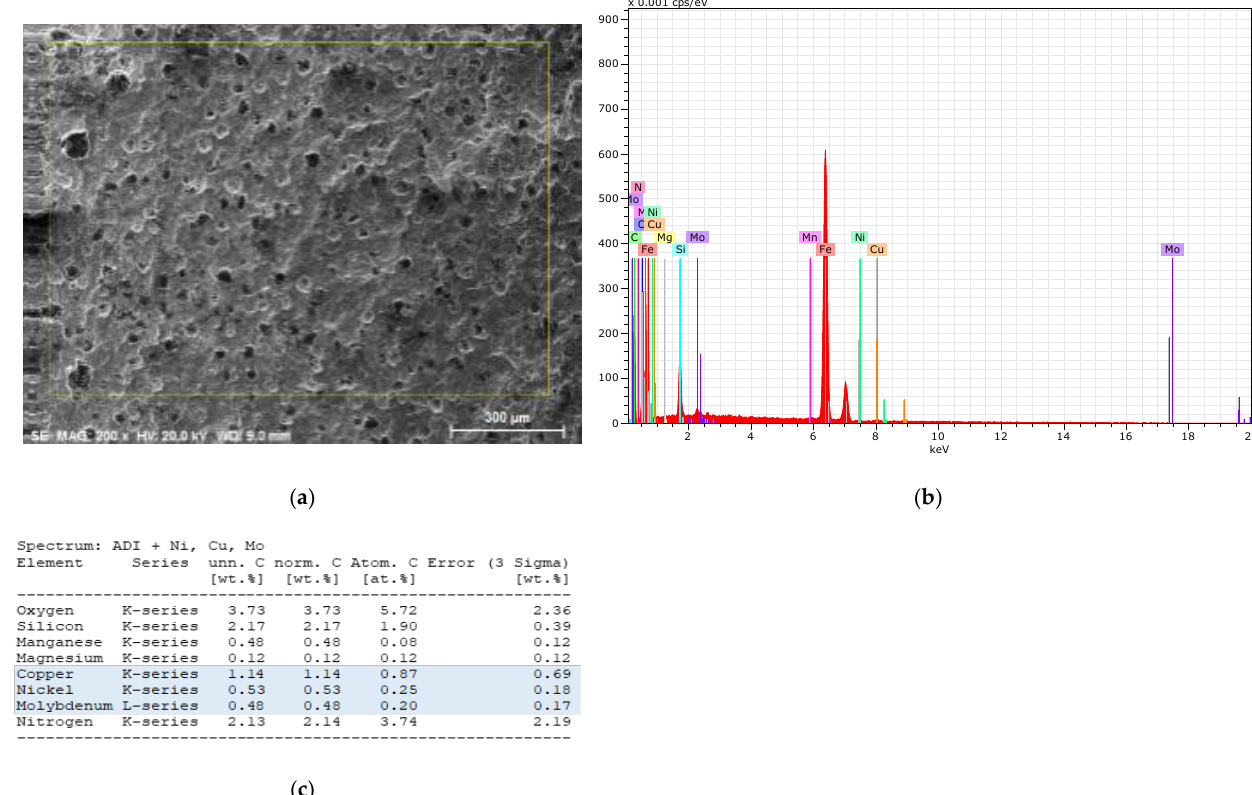
Figure 4. EDS analysis of modified ductile cast iron: ( a ) the place from which the elemental analysis was taken, ( b ) EDS spectrum resulting from analysis of inclusion presented in ( a ), ( c ) the results of elemental analysis of the material under the test.